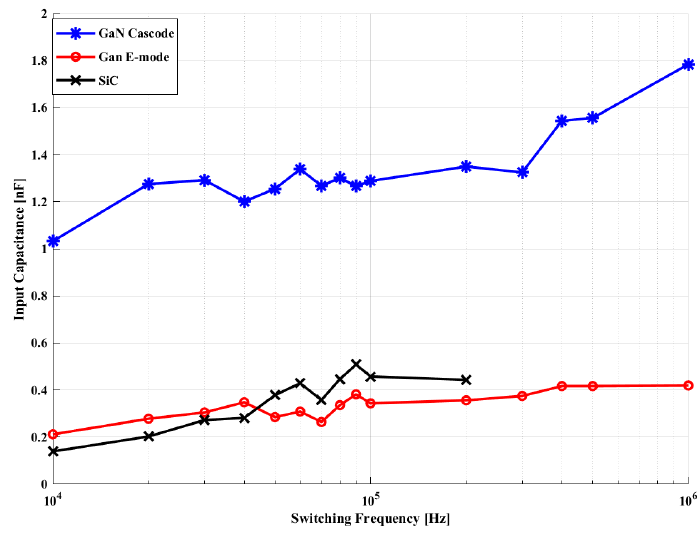
Figure 13. Input capacitance vs. switching frequency with Equation (3).